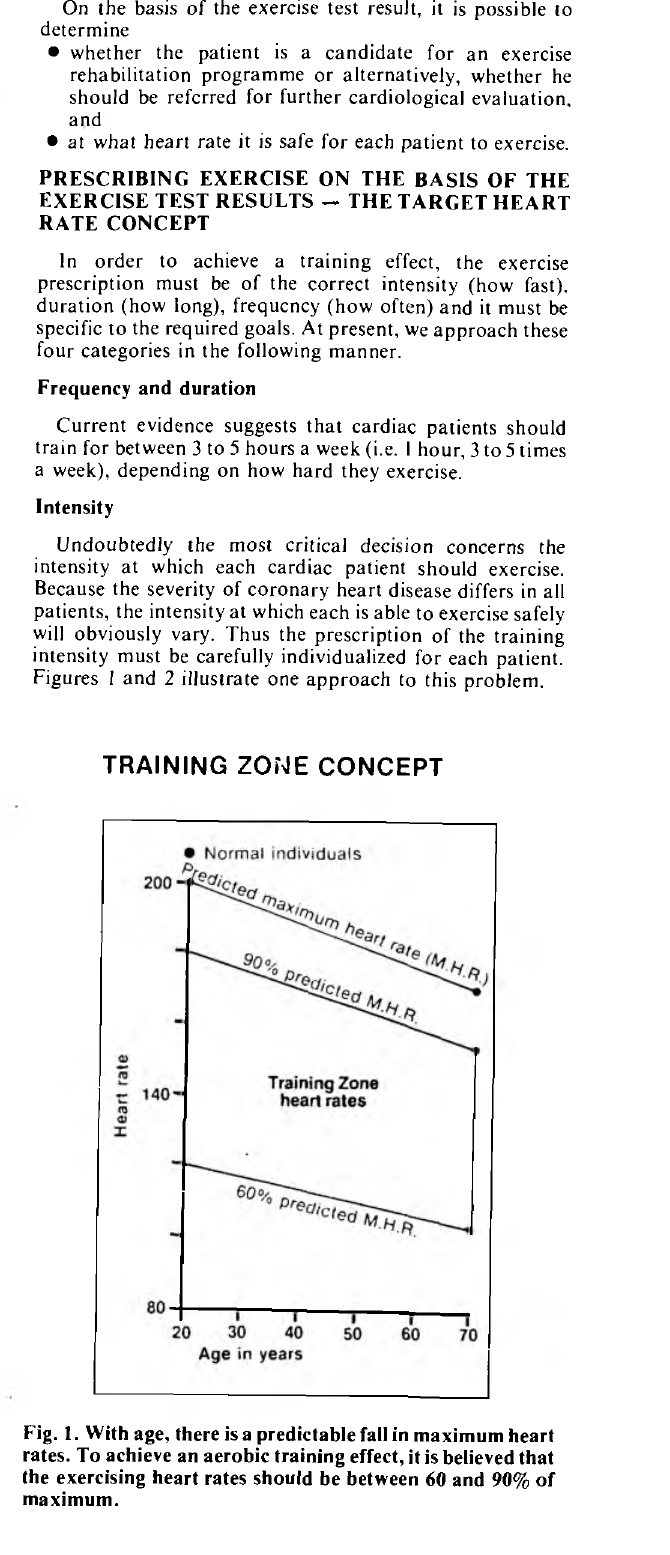
Fig. 1. With age, there is a predictable fall in maximum heart rates. To achieve an aerobic training effect, it is believed that the exercising heart rates should be between 60 and 90% of